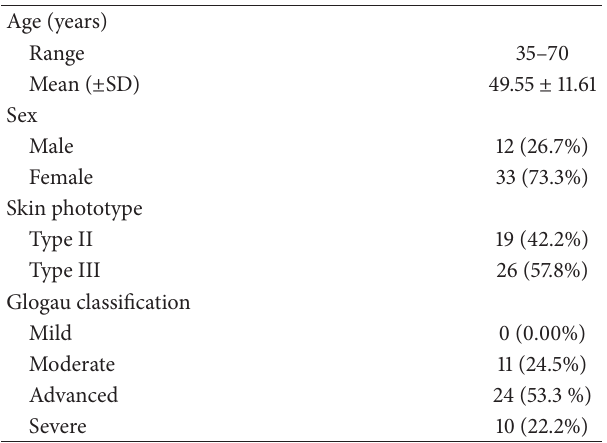
Table 2: Demographic profile and basic data of patients with